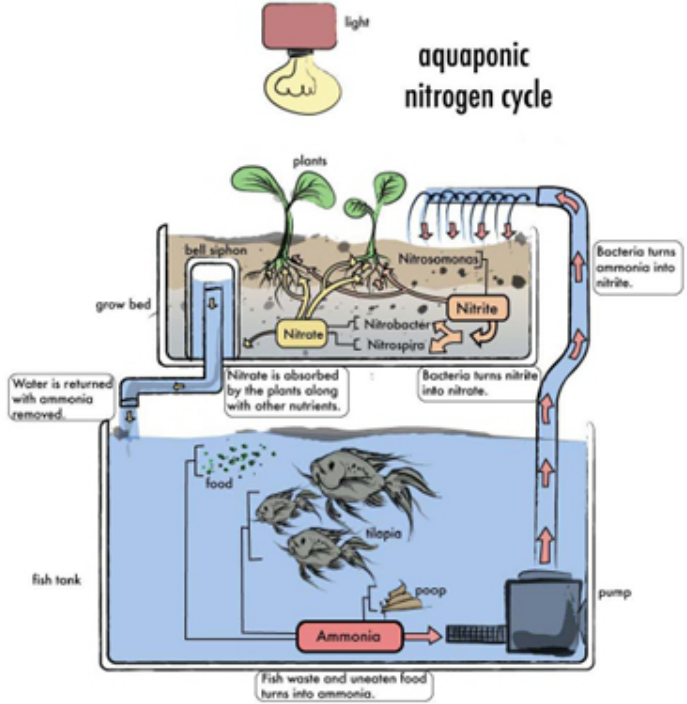
Figure 2. Work principle of an aquaponics system (Aquaponics Plans, 2009)